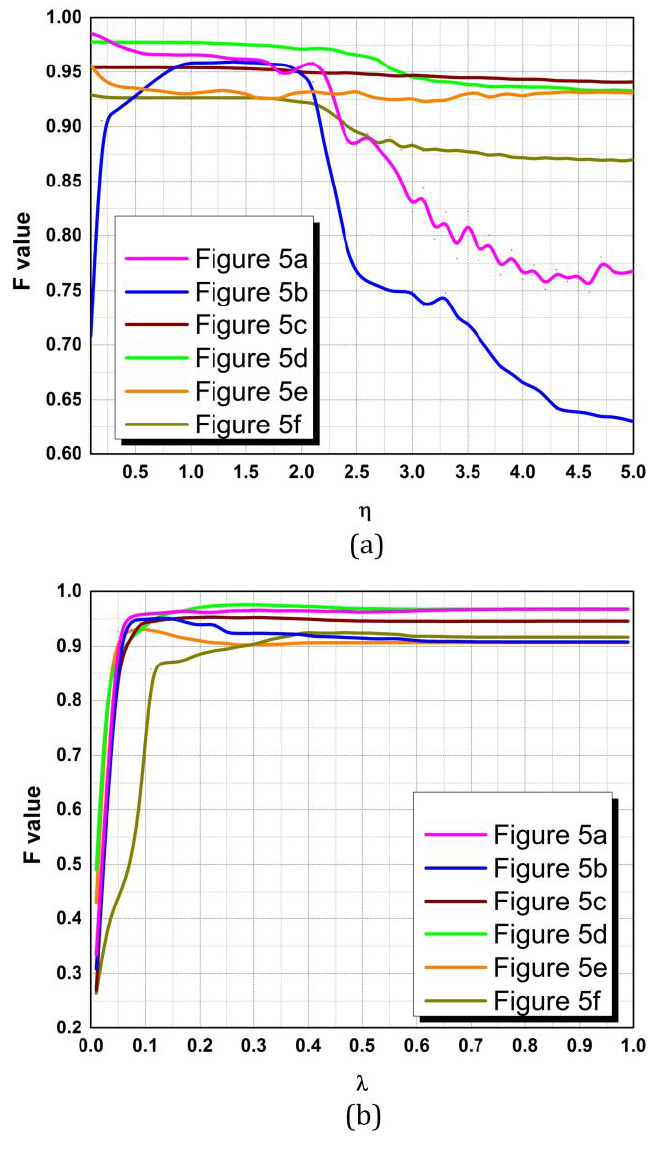
Figure 6. Sensitivity curves: ( a ) η -curves; ( b ) λ -curves.